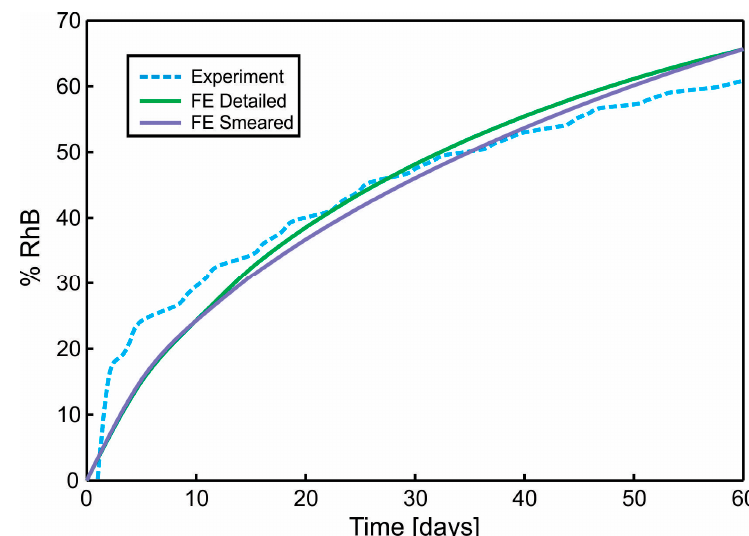
Figure 12. Diagram Cumulative Release vs. Time. Comparison of results for the true (detailed) and smeared model of PLGA nanofibers, with Span-80/RhB complex impregnated and for 24 wt.% 50:50 PLGA. Experimental curve and computational results obtained using true (detailed) and smeared model of PLGA nanofibers.